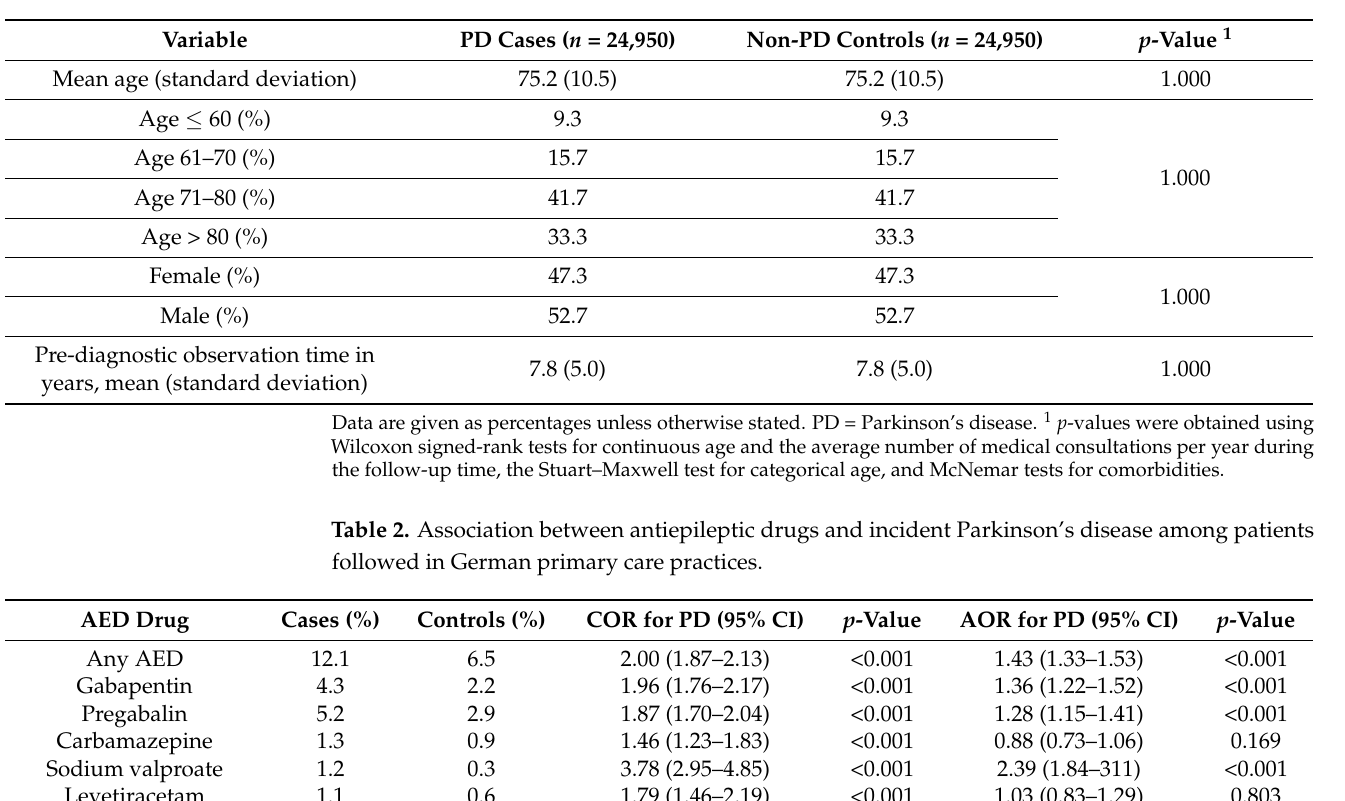
Table 1. Demographic and clinical characteristics of the study sample (after 1:1 matching).